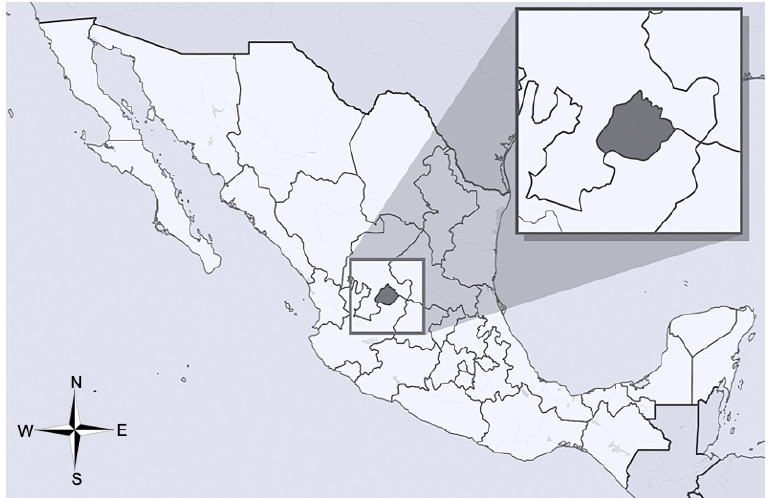
Figure 1. Aguascalientes